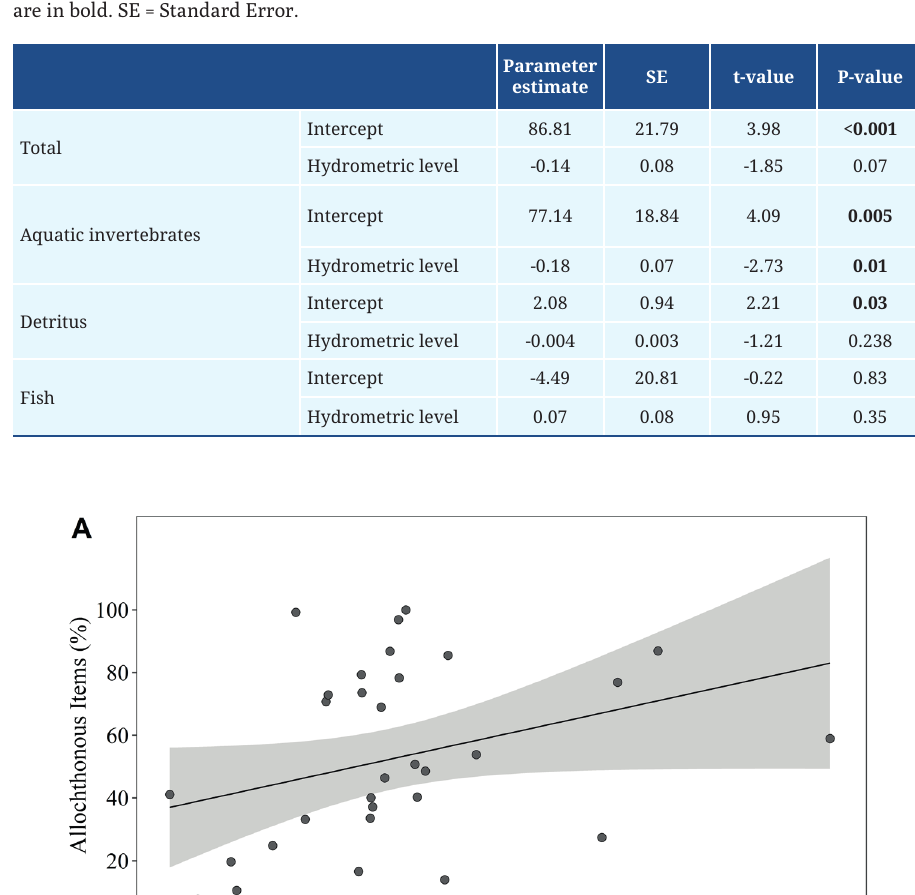
FIGURE 3 | A. Relationship between the hydrometric level and the consumption of all allochthonous items; B. The consumption of terrestrial invertebrates; C. And the consumption of terrestrial plants for Trachelyopterus galeatus. The green graphs indicate a significant positive influence of the variable as a function of hydrometric level, while grayscale graphs indicate a